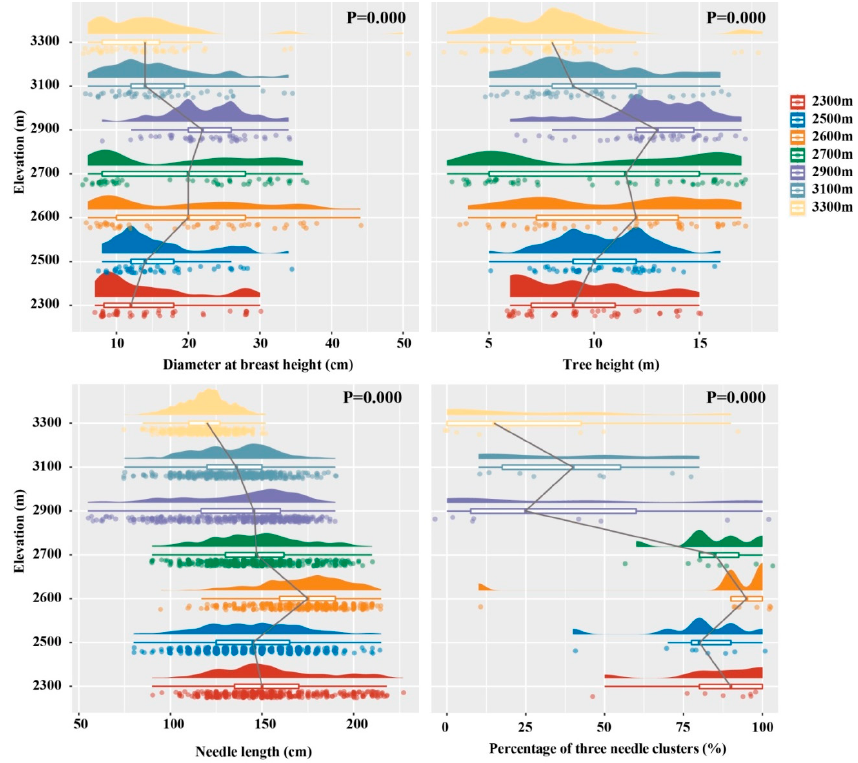
Figure 1. Raincloud plot showing morphological features at different elevations. The half-violin diagram (cloud) shows the kernel density of the data distribution, and the scatter diagram (rain) shows the degree of dispersion. The raincloud plot also includes a box plot (umbrella) and lines (thunder) that link the medians of different groups.